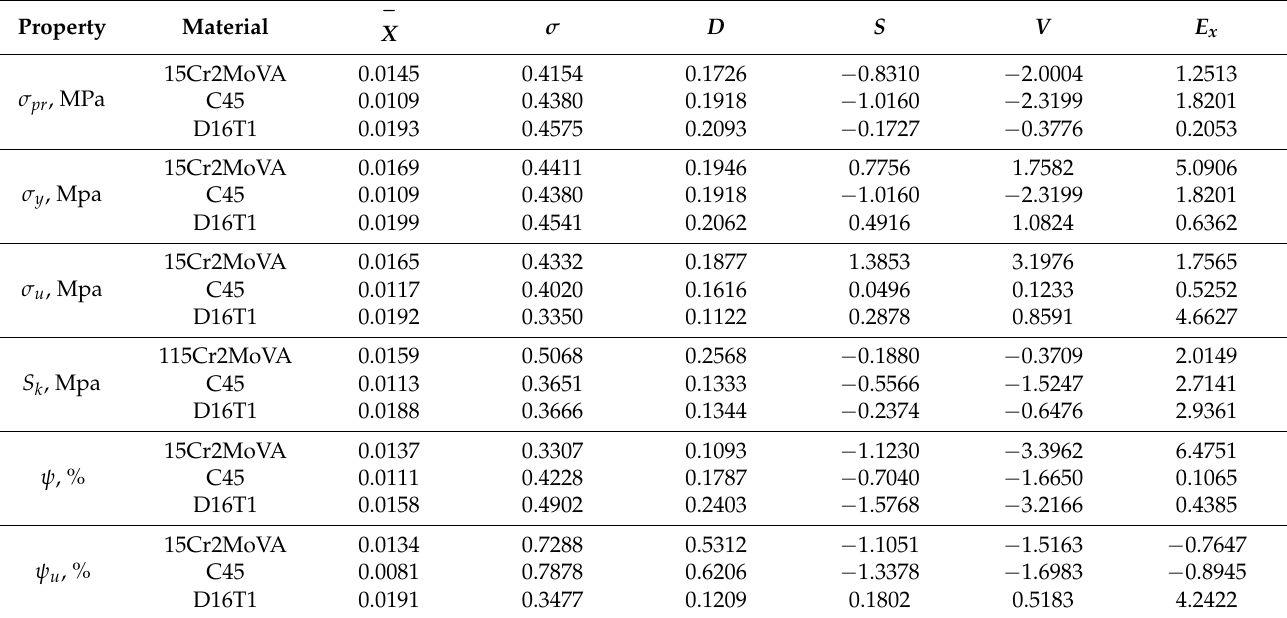
Table 6. Statistical properties for mechanical properties of structural materials under the logarithmic- normal law taking into account sensitivity thresholds N 0 and N k .